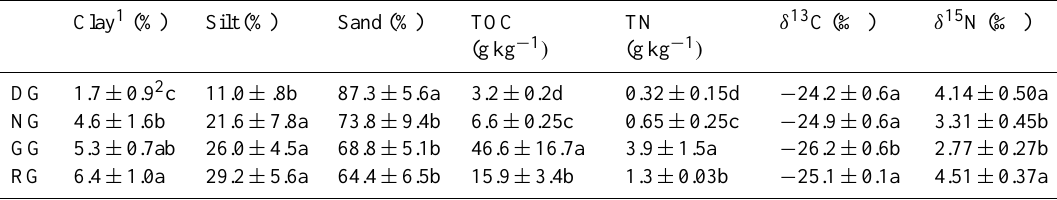
Table 1. Grain size distribution, total organic carbon (TOC), total nitrogen (TN), δ 13 C and δ 15 N values of soils from degraded grassland (DG), native grassland (NG), GG groundwater-sustaining grassland (GG) and restored grassland (RG) in Inner Mongolia. Four soil samples were analyzed for each type of grassland.